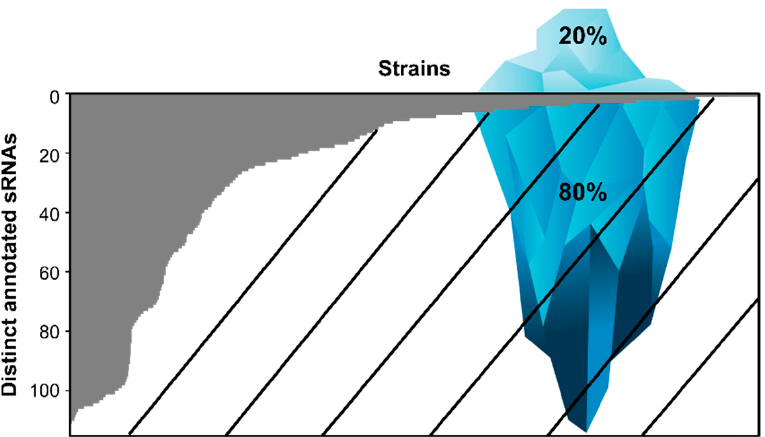
Figure 1. Number of distinct annotated sRNAs per bacterial strain in Proteobacteria. The iceberg is intended to be a graphical representation of the knowledge we have about the prevalence of sRNAs in Proteobacteria (gray section) as opposed to what we could be missing (hatched section). The ratio of the surface versus underwater portions of the iceberg is proportional to results represented in the graph, where the gray region is what is known (i.e., the visible part of the iceberg), and the hatched area under that region is what could be left to discover (that is, the underwater section of the iceberg). Percentages also represent this ratio. This figure represents a compilation of 2629 strains. Only sRNAs with an E-value lower than 0.0005 were